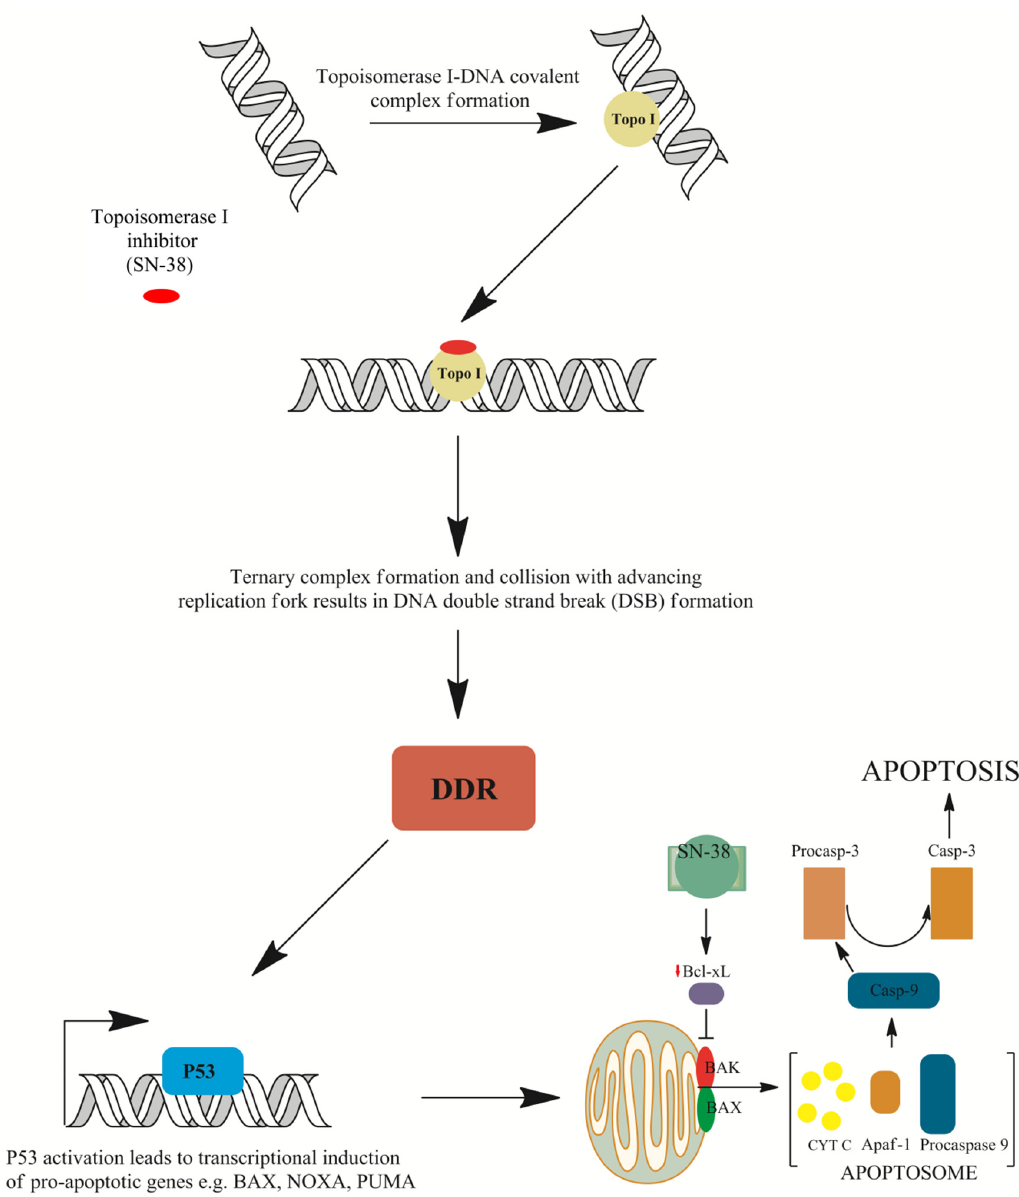
Figure 4. Mechanisms of cell death induced by irinotecan. The ternary irinotecan–topoisomerase I–nicked DNA complex with topoisomerase I (Topo I) inhibitor (SN-38) disables religation of the nicked strand and prevents topoisomerase release. Collision of the formed complex with advancing replication forks results in the formation of double-strand breaks (DSBs). This is followed by DNA damage response (DDR) signaling and TP53-induced gene expression of pro-apoptotic genes such as apoptosis regulator (BAX), phorbol-12-myristate-13-acetate-induced protein 1 (NOXA), or p53 up-regulated modulator of apoptosis (PUMA). Furthermore, down-regulation of the Bcl-2-like protein 1 isoform protein (BCL-xL) protein allows BAX and Bcl-2 homologous antagonist (BAK) embedding into the mitochondrial membrane and the formation of pores that allow the release of cytochrome C (cytC) from mitochondria and the subsequent formation of apoptosome with apoptotic protease-activating factor 1 (APAF-1) protein and procaspase-9. The activation of procaspase to caspase 9 (Casp-9) results in proteolytic cleavage and the conversion of procaspase 3 into active caspase 3 (Casp-3), which executes apoptosis [37,38,44,49,51].